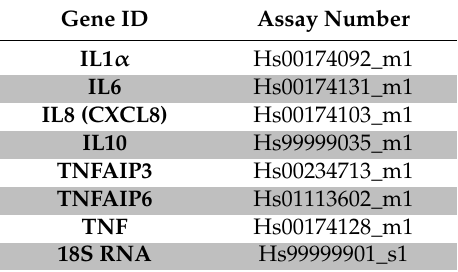
Table 4. TaqMan Gene Expression